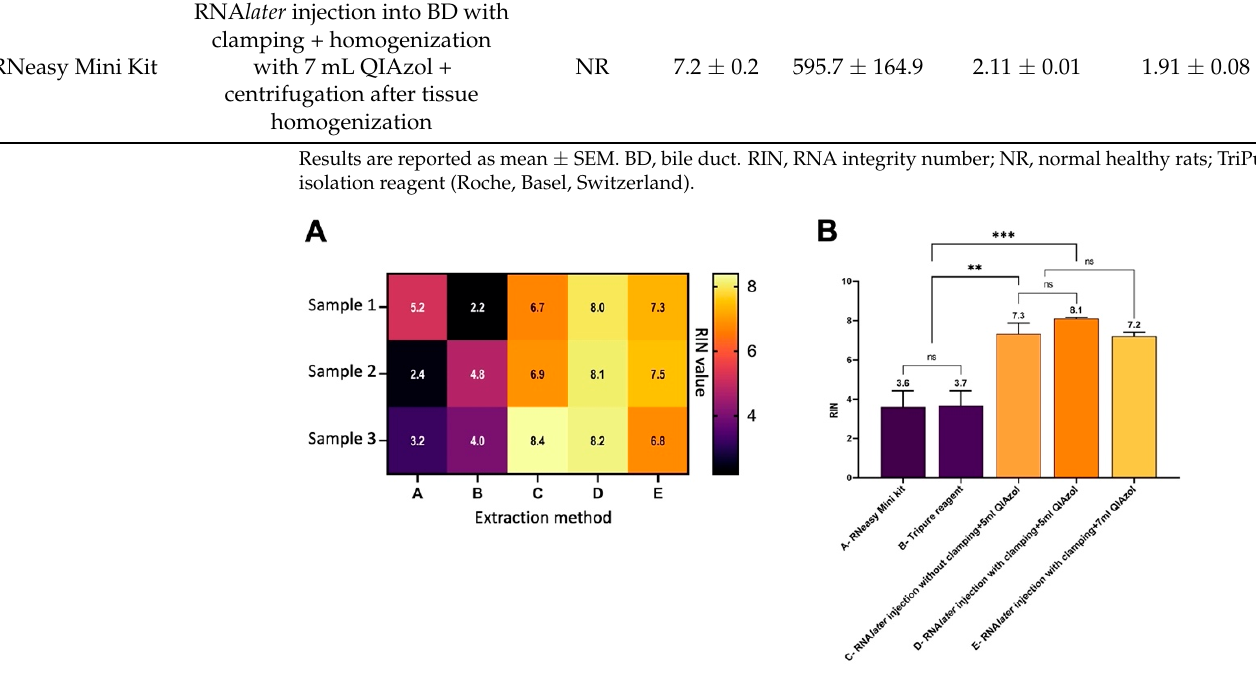
Figure 3. Comparison of RNA integrity number (RIN) values of pancreatic RNA samples from healthy rats following different excision techniques and extraction protocols demonstrated as ( A ) a heat map with the three RIN values of each protocol reported inside boxes and ( B ) a bar graph showing the significant difference in RNA integrity between the optimized and standard protocols using the standard one-way analysis of variance (ANOVA) for RNA analysis followed by Fisher’s LSD test. ns, non-significant ( p > 0.05) or significant at ** p < 0.01, *** p < 0.001.